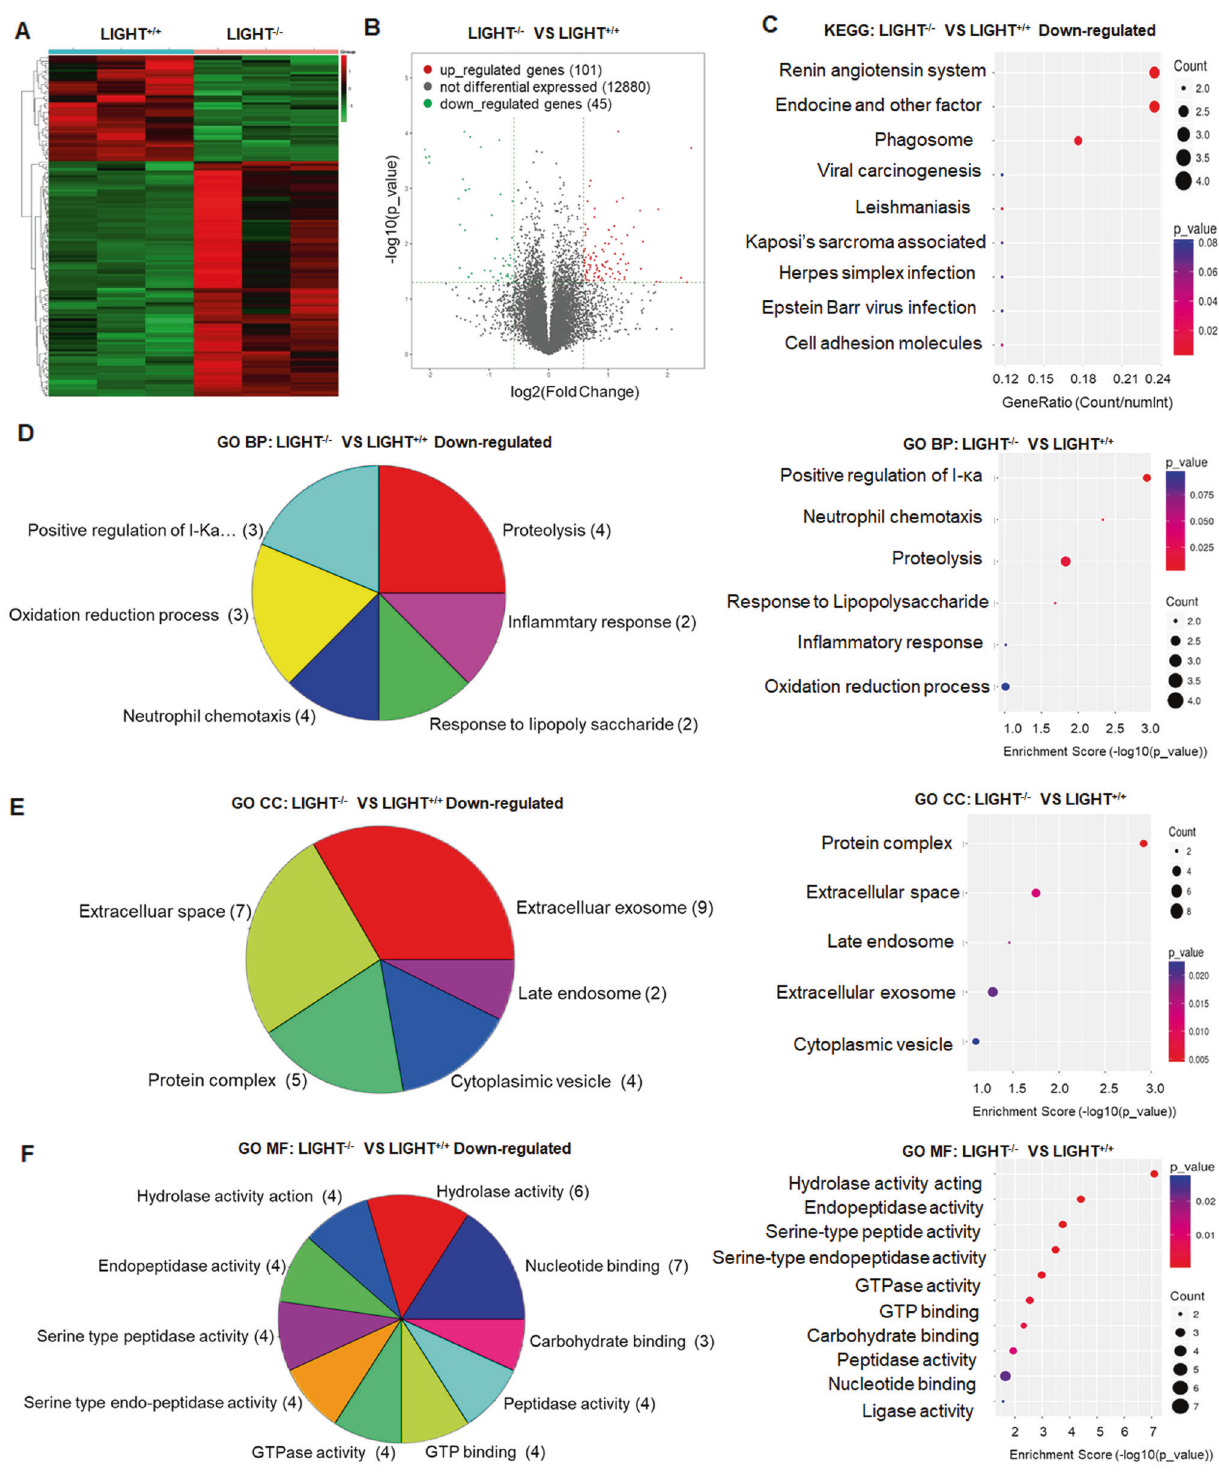
Fig. 2 LIGHT de fi ciency affects RNA expression encoding the oxidation process, in fl ammation, and cell injury. Wild-type (LIGHT + / + ) and LIGHT (LIGHT − / − ) mice were conducted with renal ischemia followed by reperfusion for 24 h. Renal samples were collected and underwent transcriptome analysis. ( n = 3 for each group). The heat map ( A ), volcano plot ( B ) graphs are shown. C KEGG analysis of downregulated genes in LIGHT − / − mice, compared with that in LIGHT + / + mice. D – F The Gene Ontology (GO) results of downregulated genes for LIGHT + / + vs. LIGHT − / − . Differentially expressed genes (DEGs) were divided into three domains: biological process (BP), cellular components (CC), and molecular function (MF). Left panel: DEGs counts according to the classi fi cation strategy. Right panel: enrichment scores of DEGs.